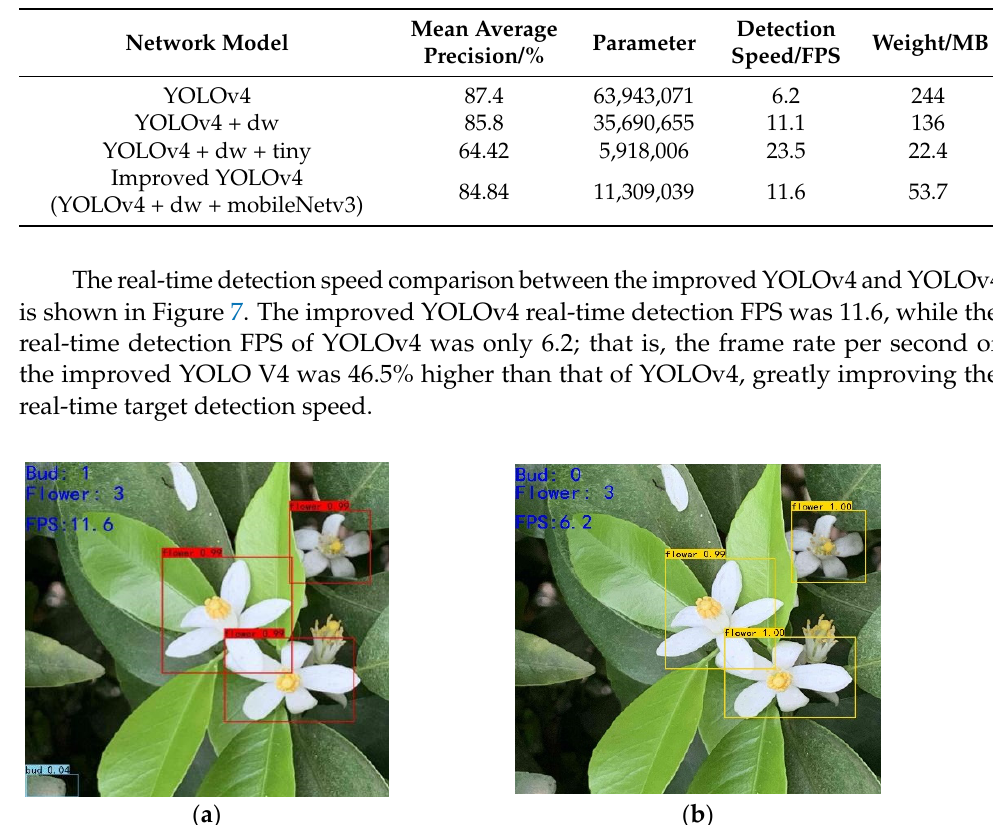
Table 1. Improved YOLOv4 ablation experiment.